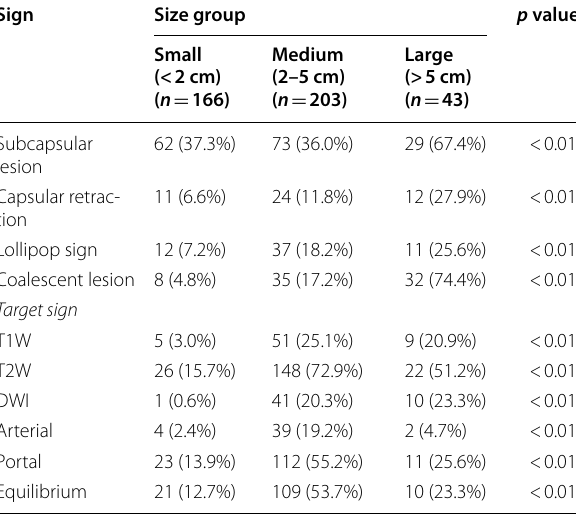
Table 2 Comparison of MRI features among lesions in different size groups